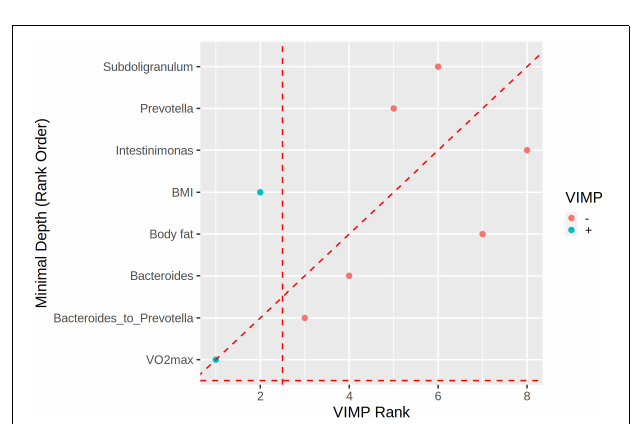
FIGURE 6 | The plot depicting the ranking of predictors by graph depth ( y -axis) vs. variable importance (VIMP, x -axis). VO2max is the best variable for both criteria. The Bacteroides to Prevotella ratio is the second most important by the VIMP criterion whereas it is the fourth most important by the graph depth. Overall, the two criteria are in good agreement in ranking the